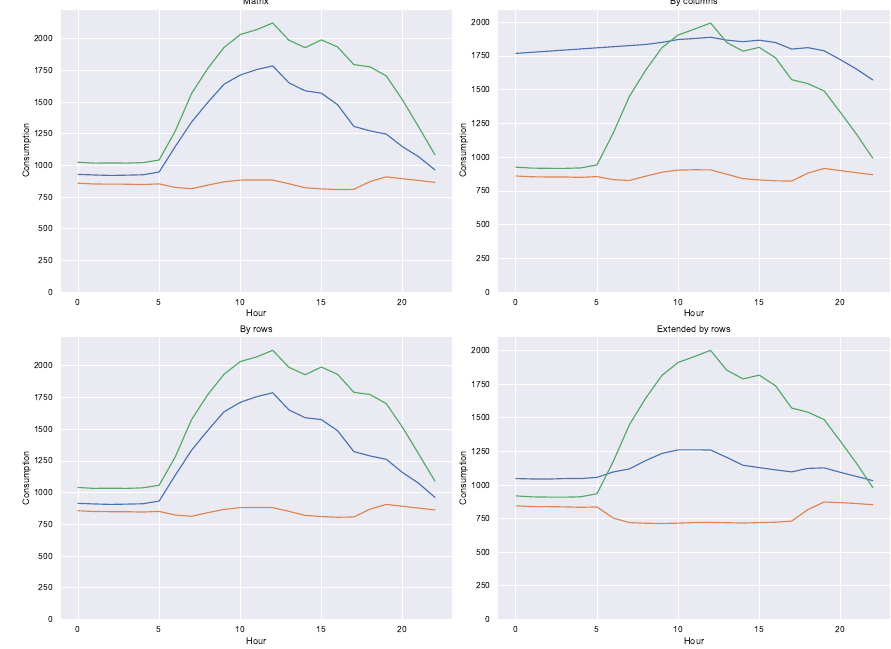
Figure 4. Averege profiles for three different